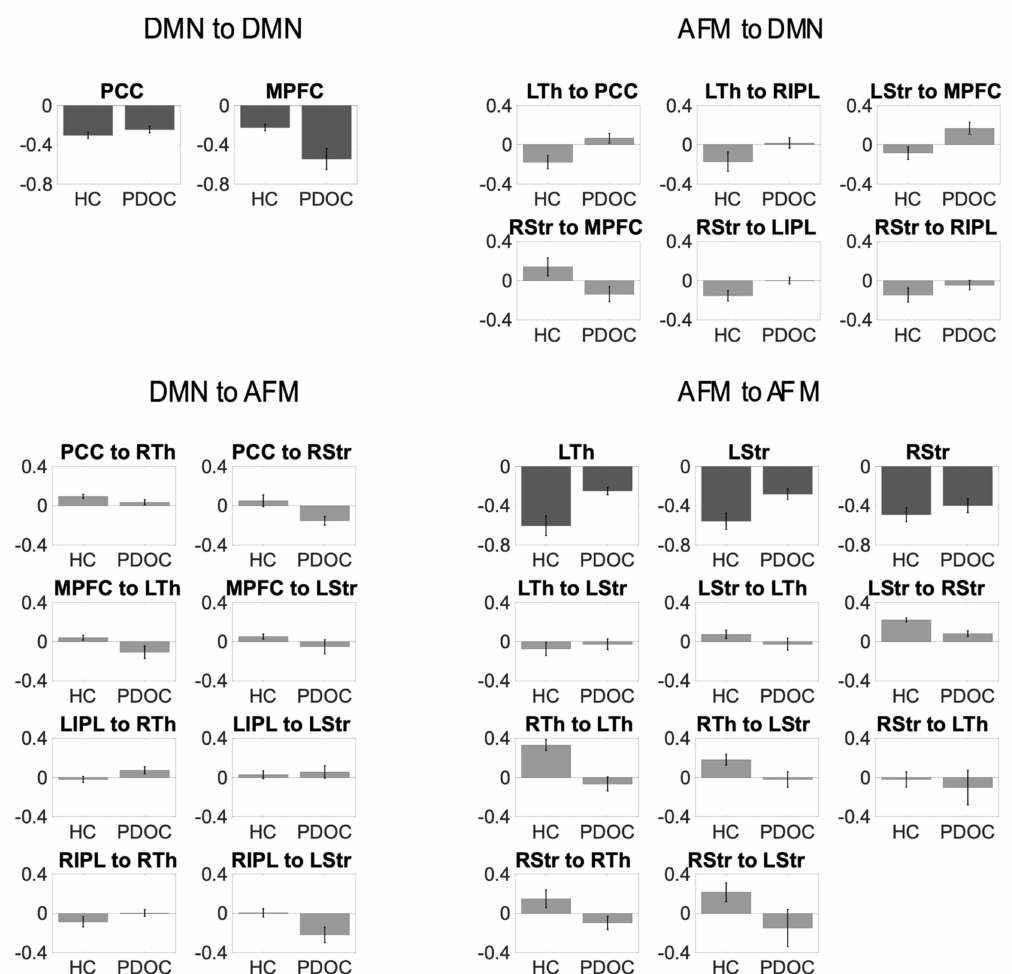
Figure 3. Mean connection strength (Ep.A) for the connections contributing to the difference between groups. Error bars represent standard error. Self-connections appear in darker grey and have been converted into Hz. PCC, posterior cingulate cortex/precuneus; MPFC, medial prefrontal cortex; LIPL, left inferior parietal lobule; RIPL, right inferior parietal lobule; LTh, left thalamus; RTh, right thalamus; LStr, left striatum; RStr, right